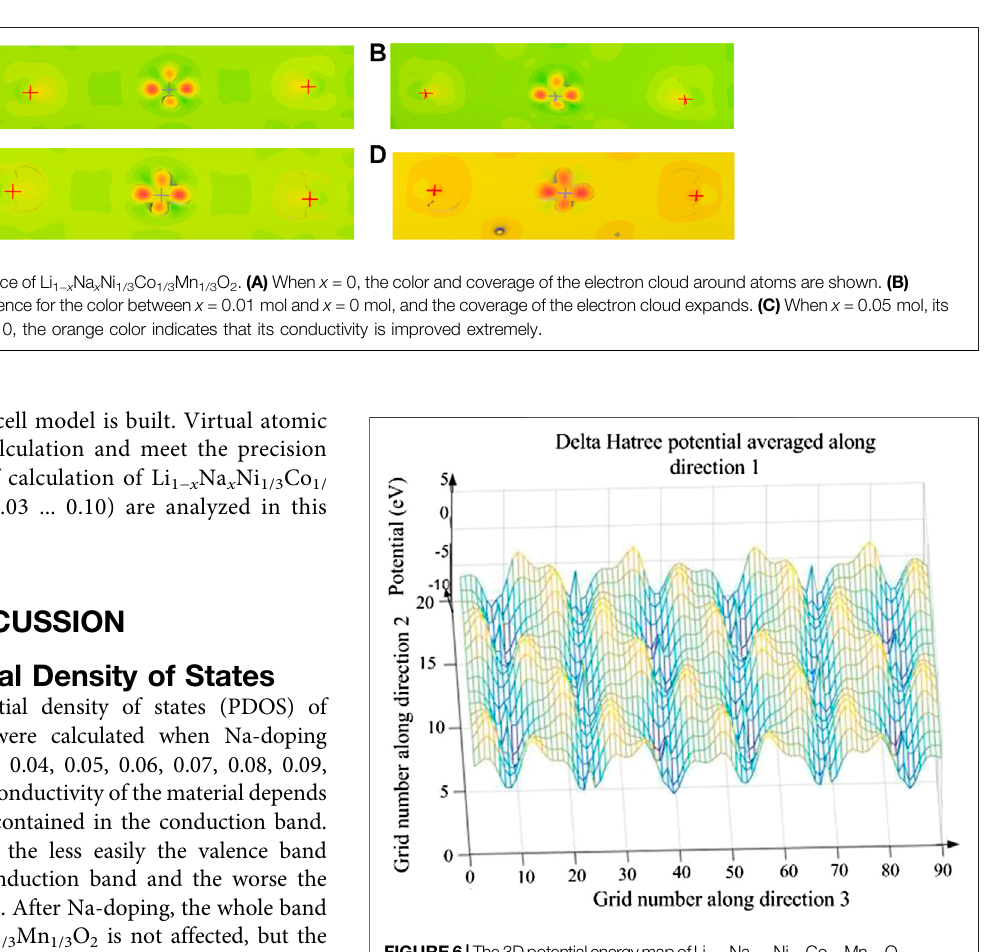
FIGURE6| The3DpotentialenergymapofLi 0.95 Na 0.05 Ni 1/3 Co 1/3 Mn 1/3 O 2 . The potential barrier and potential well take turns, which is consistent with the layered structure of Li 0.95 Na 0.05 Ni 1/3 Co 1/3 Mn 1/3 O 2